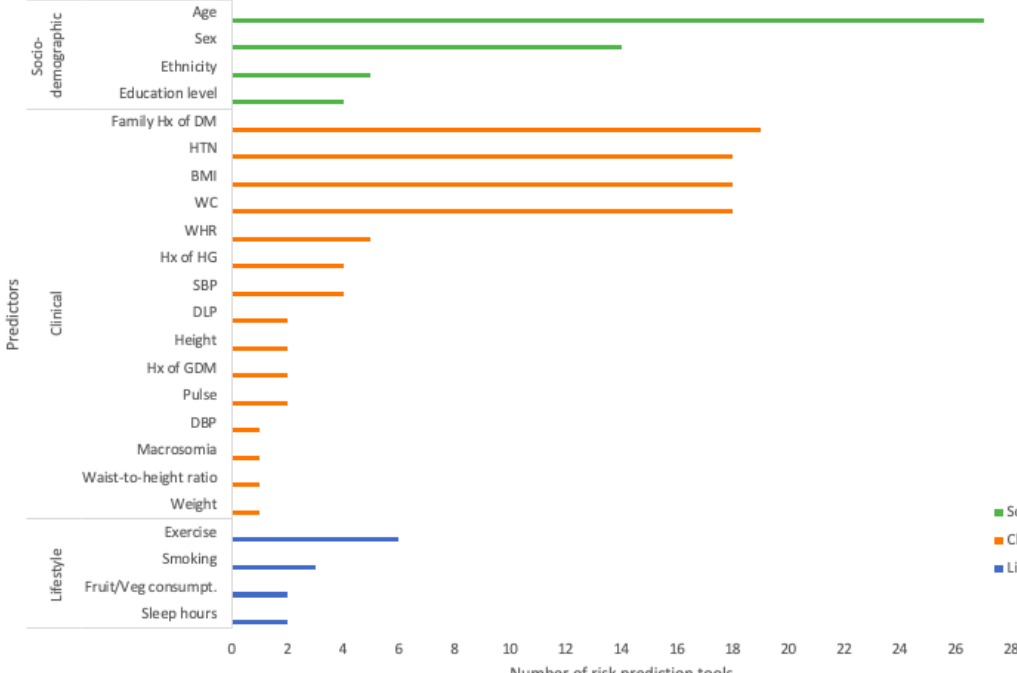
Figure 2. Non-laboratory-based predictors among existing prediction tools.